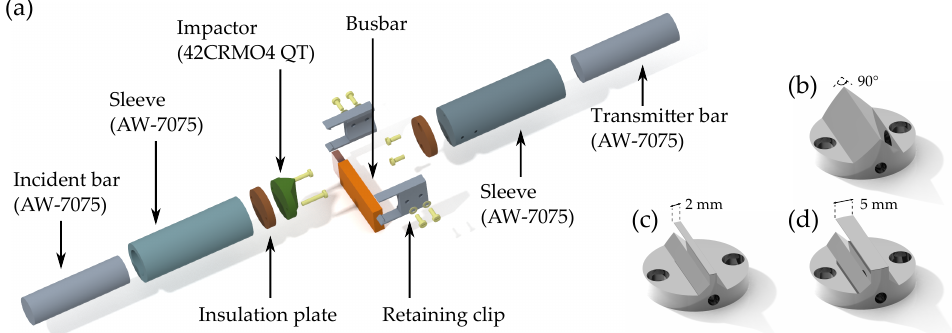
Figure 3. Explosion view of the immediate test area between the incident bar and transmitter bar ( a ), overview of the used impactor shapes V1 ( b ) V5 ( c ) and V4 ( d